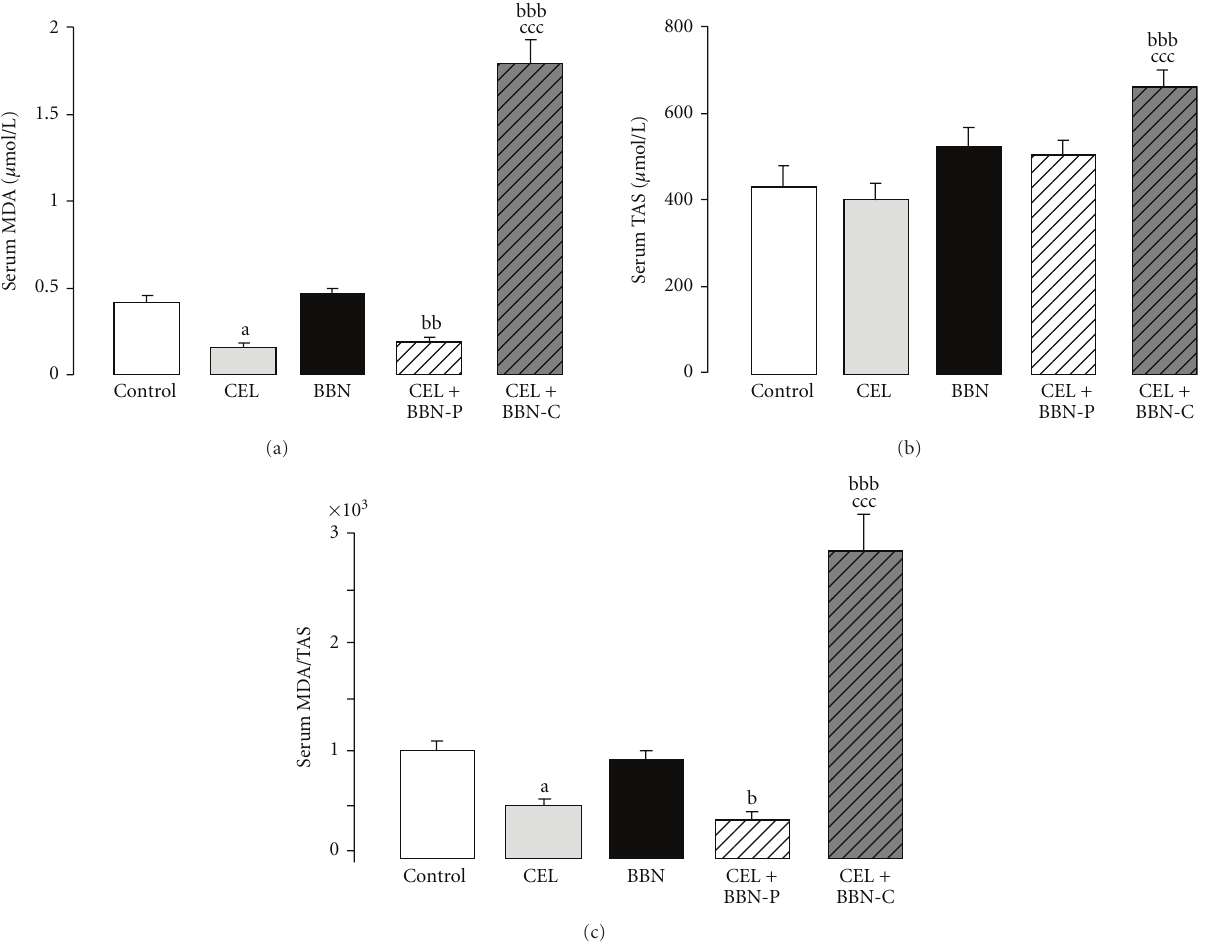
Figure 4: Serum markers of redox status: lipid peroxidation, through MDA (a), total antioxidant status (b), and MDA/TAS (c)—in the five groups under study. Values are mean ± SEM. a - P < . 05 versus the control group; b - P < . 05, bb - P < . 01, and bbb - P < . 001 versus the BBN group; ccc - P < . 001 versus the CEL+BBN-P